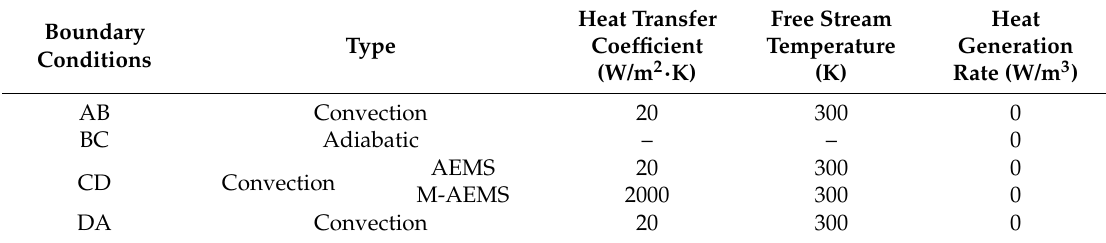
Figure 3. A schematic view of axisymmetric calculation domain and its mesh plot in the heat-transfer model: ( a ) axisymmetric calculation domains and ( b ) mesh plot. Table 1. Boundary conditions used in this study.